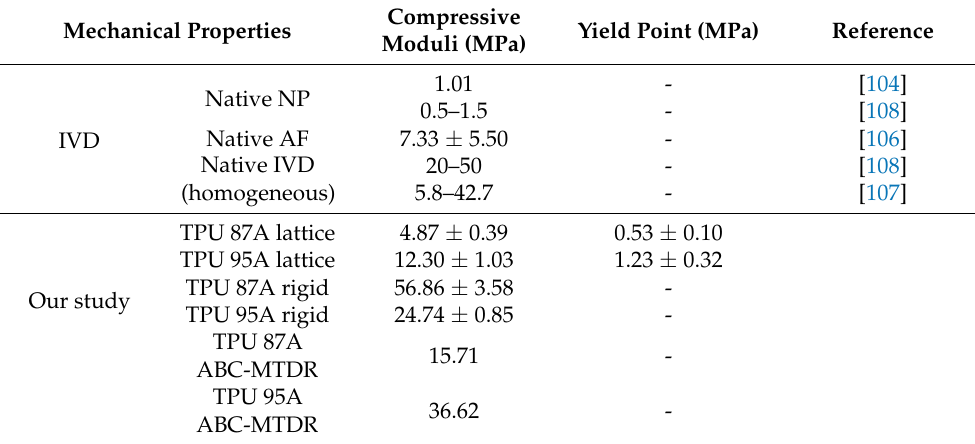
Table 2. Mechanical properties between IVD regions and our proposed